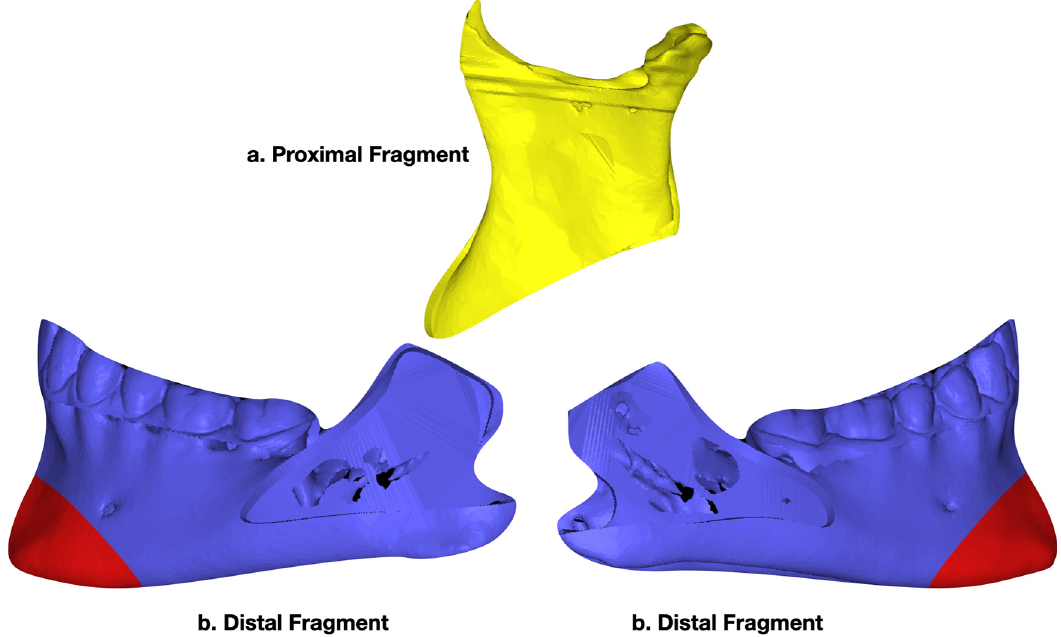
Fig. 2. (a) Proximal fragment (yellow), ( b) Distal fragments (purple). *Digital Images have been taken in NemoStudio, NemoFAB, Version